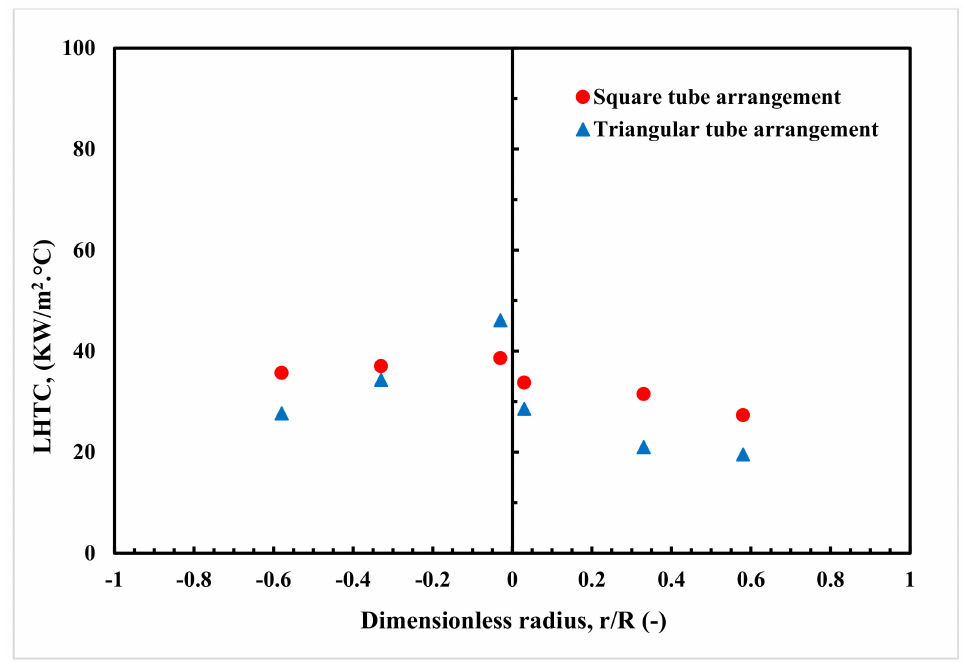
Figure 9. LHTC profiles measured at the axial level of 65 cm and an operating gas velocity of 0.25